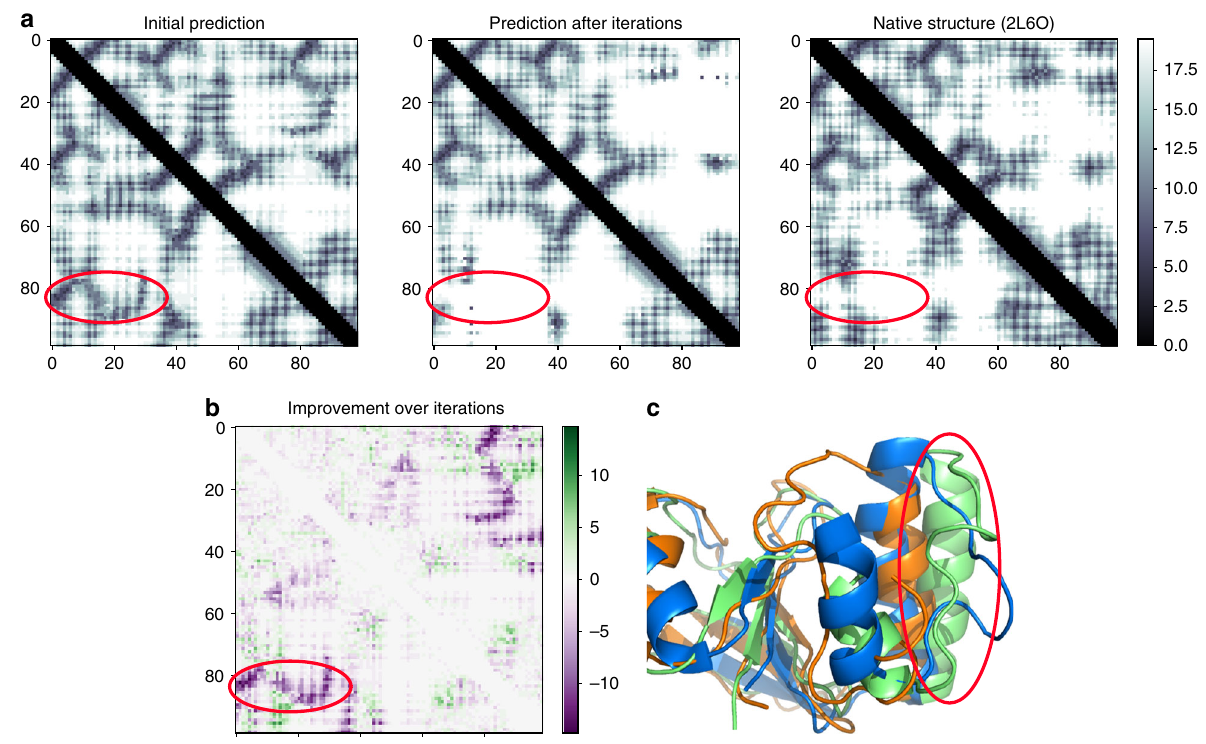
Fig. 6 An example of model accuracy increasing after iterations. The model is for Pfam family PF13642. a Distance maps of the initial prediction, the prediction after iterations and the native structure. In each case the value at i , j is the centre of the distance bin with the maximum likelihood between residues i and j . b The change of the absolute error in distance from the initial prediction to the prediction after iterations. A negative value indicates an improvement with the iterations. c The improvement is shown on the structure. The native structure (PDB ID 2L6O) is in blue, the initial model is in orange and the model after iterations is in green. The loop region indicated in red throughout, and the following helix, are closer to the native structure in the prediction after iterations than the initial